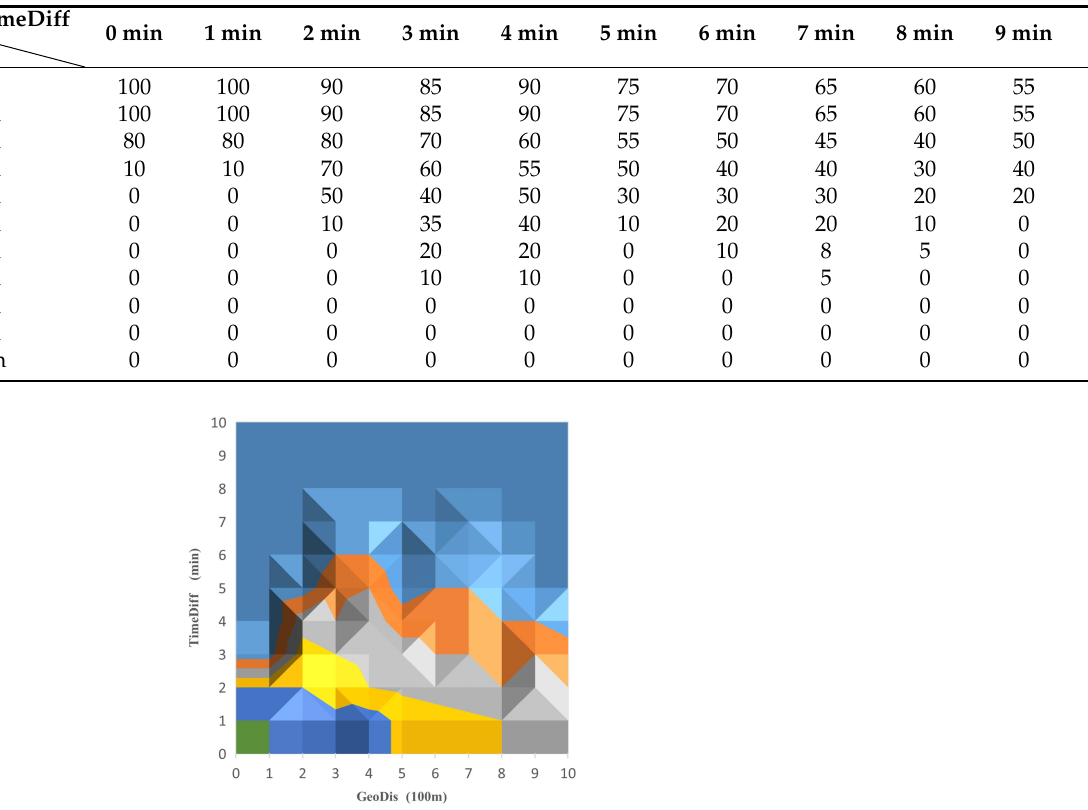
Table 3. Labeled matrix of affinity score for a face–phone trajectory point pair.